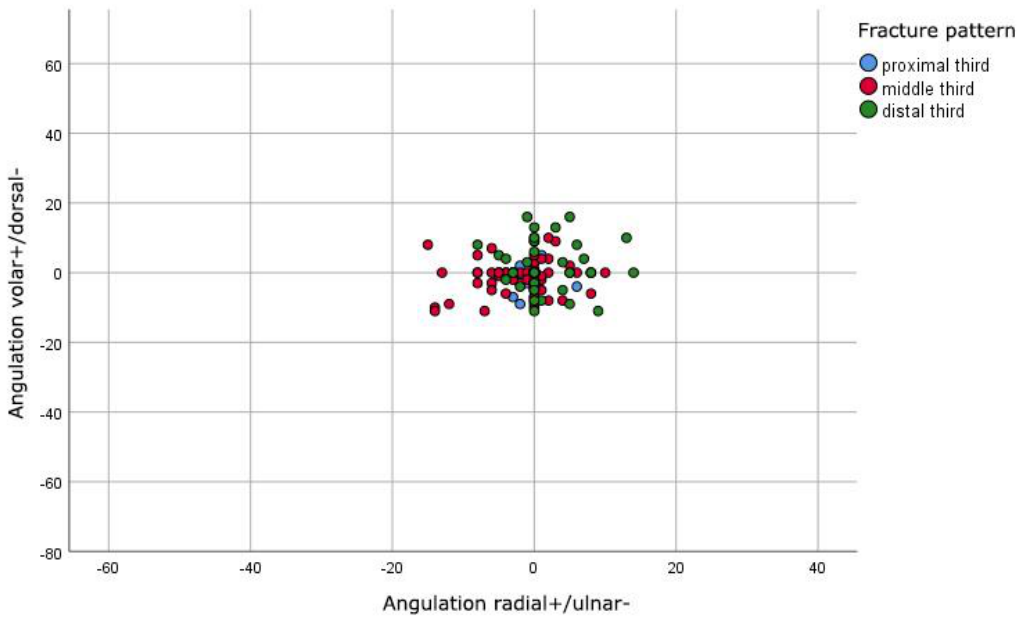
Figure 2. Postoperative distribution of angulations in degrees of fractures in anterior–posterior (x axis) and lateral (y axis) plane.